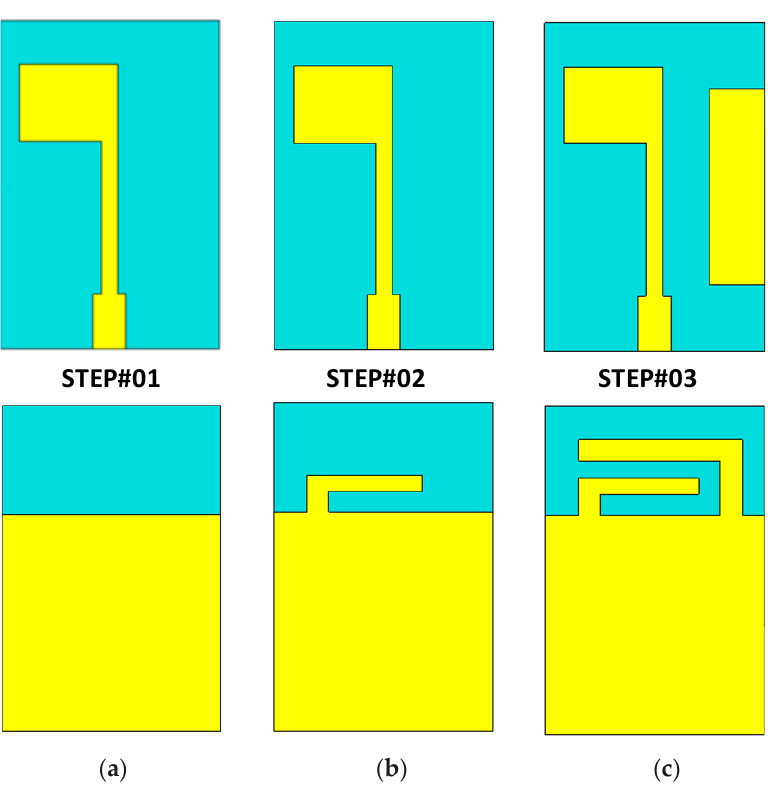
Figure 3. Proposed antenna design steps: ( a ) simple patch with partial ground (ANT I); ( b ) patch with one pole on the ground (ANT II); ( c ) patch with parasitic element and two poles on the ground plane (ANT III).